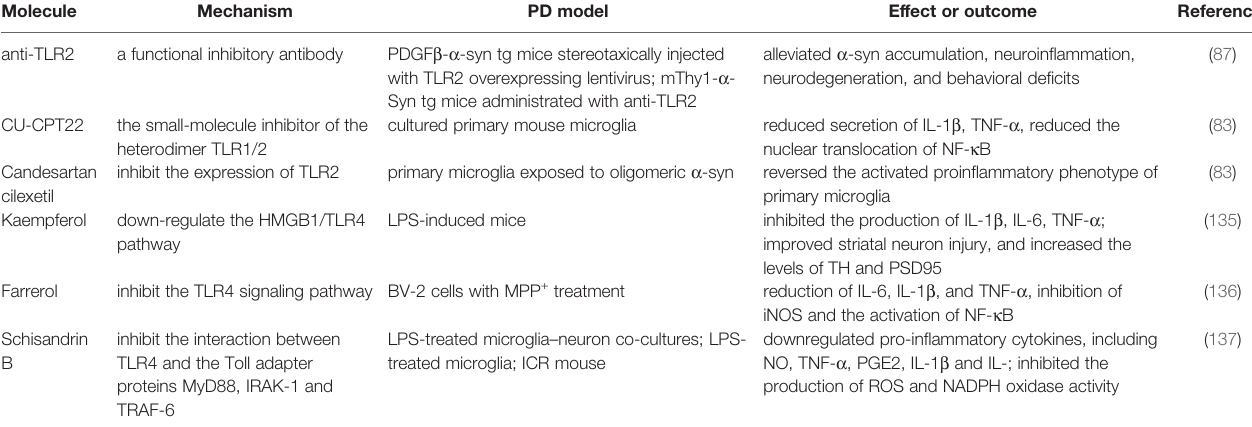
TABLE 3 | Molecules targeting TLRs.